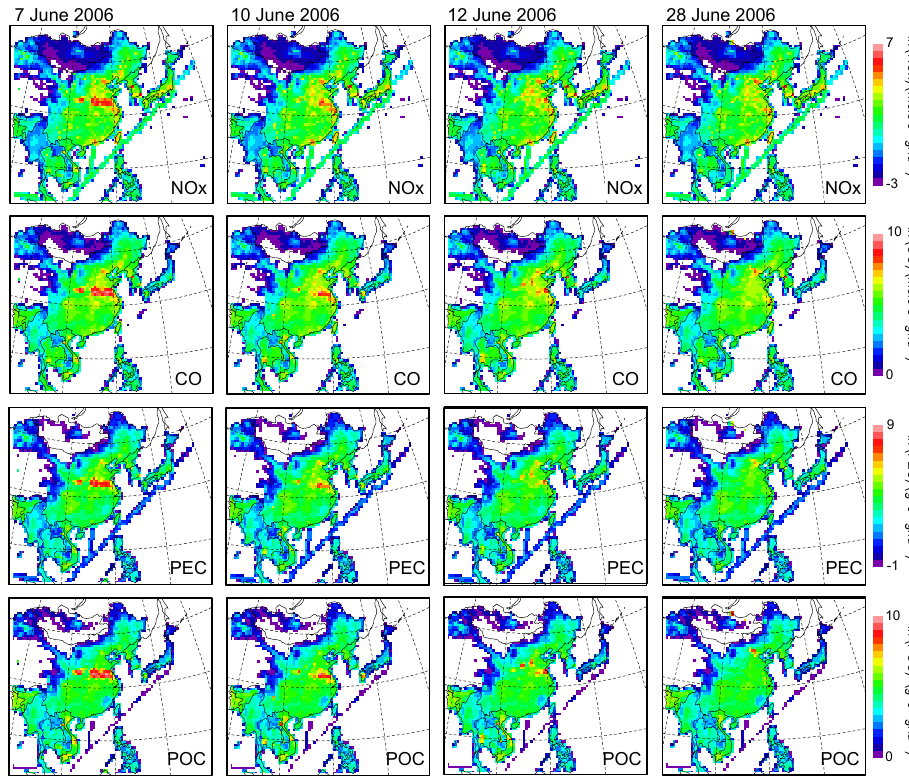
Fig. 4. Spatial distributions of daily NO x , CO, PEC and POC emissions from all sources on 7, 10, 12 and 28 June 2006.